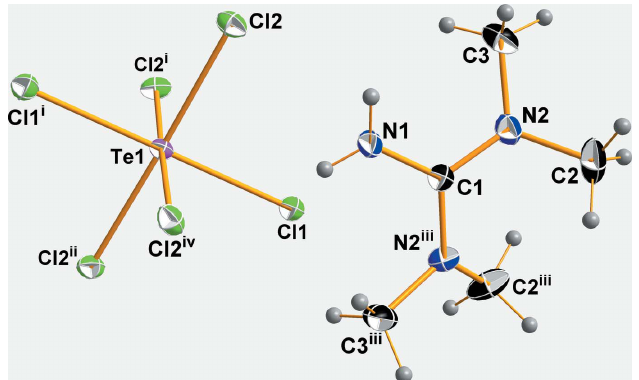
Figure 1 The molecular structure of the title compound with displacement ellipsoids drawn at the 50% probability level. Symmetry codes: (i) (cid:3) x + 7 , y , (cid:3) z + 3 ; (ii) (cid:3) x + 7 , (cid:3) y + 3 , z ; (iii) (cid:3) x + 3 4 4 4 4 (cid:3) z + 3